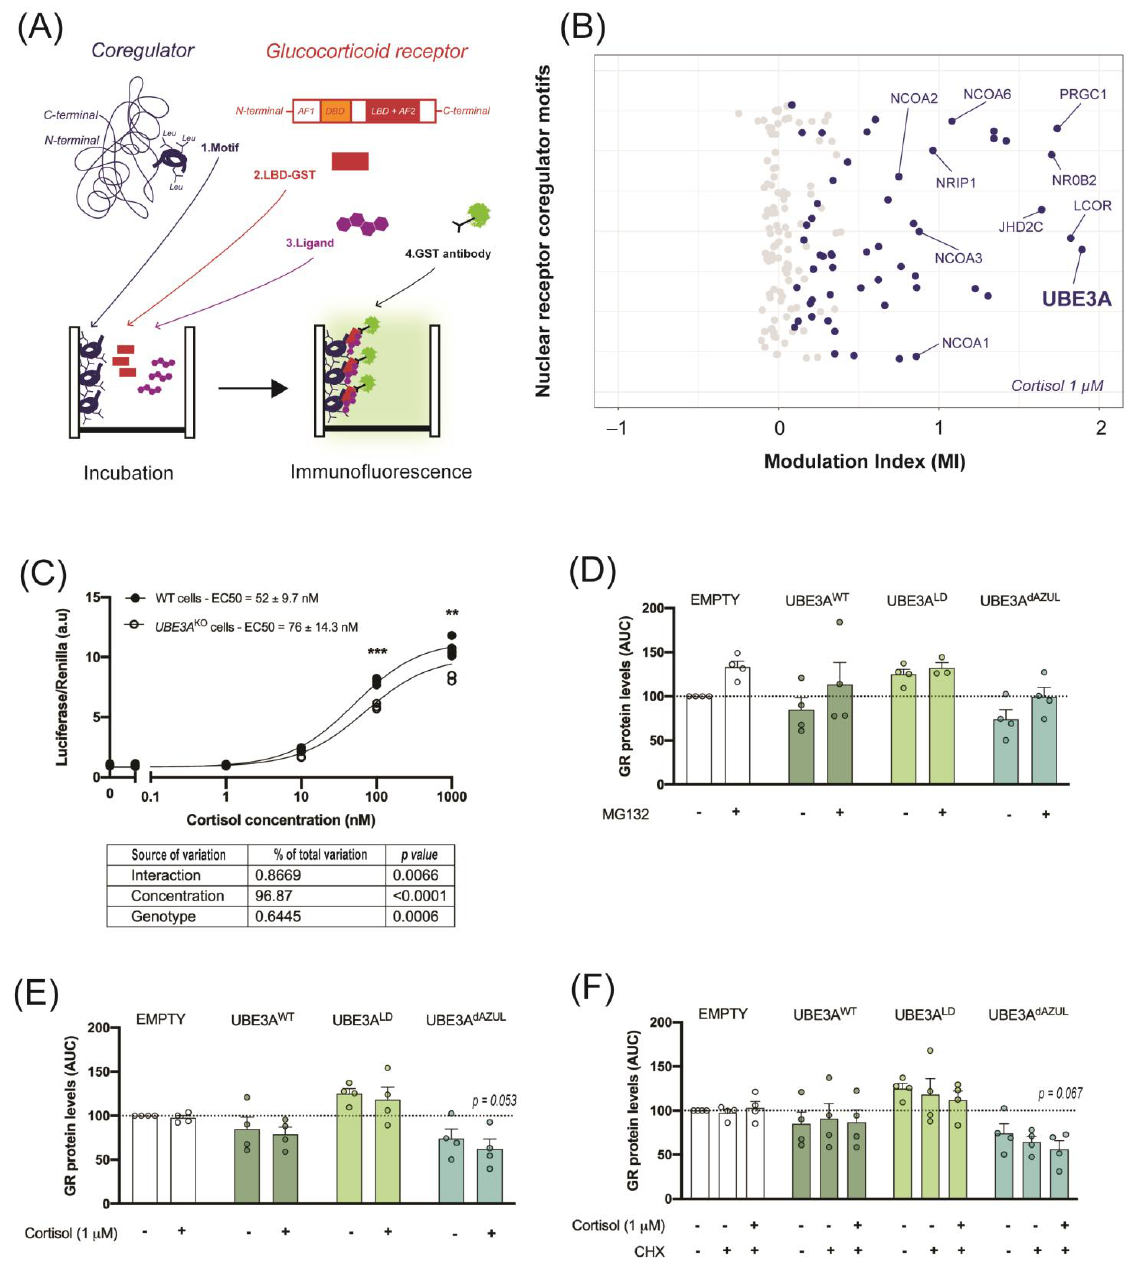
Figure 1. UBE3A interacts with the GR ligand binding domain and slightly alter GR activity and stability. ( A ) Schematic representation of the Microarray Assay for Realtime Coregulator-Nuclear receptor Interaction (MARCoNI) applied to the GR. Short leucine-rich binding motifs correspond- ing to known nuclear receptor coregulators (1. Motif) were incubated with the GR LBD tagged with Glutathione S-transferase (2. LBD-GST) and a GR ligand (3. Ligand). The interaction between a motif and the GR LBD was detected with a GST-specific antibody coupled to a fluorophore (4. GST anti- body). ( B ) Interaction of the GR LBD with 154 short leucine-rich binding motifs of 64 known nuclear receptor coregulators as measured by the modulation index (MI) in the presence of 1 µM cortisol.